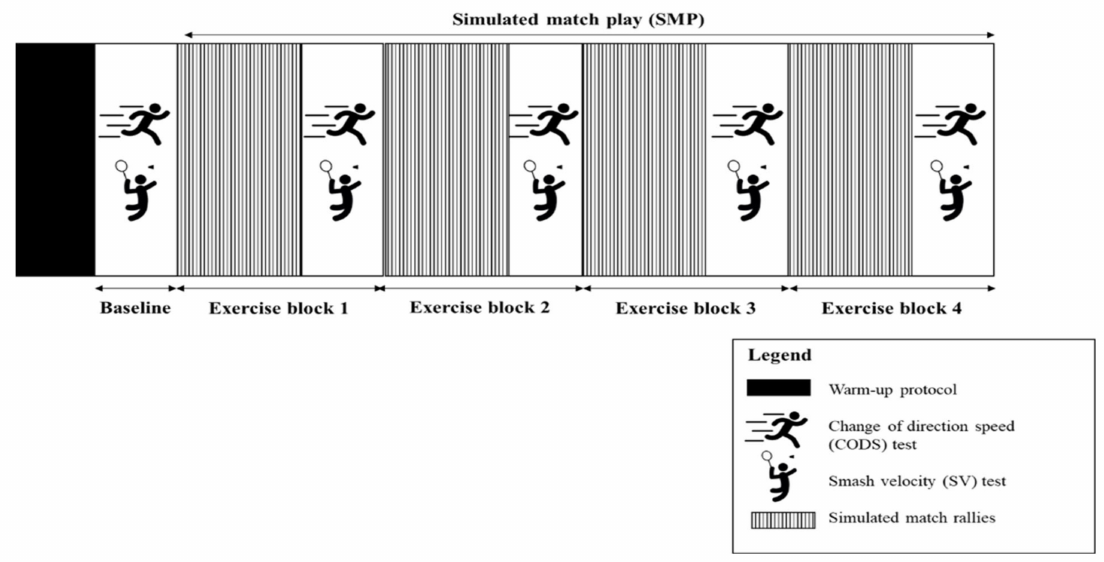
Figure 1. Study experimental